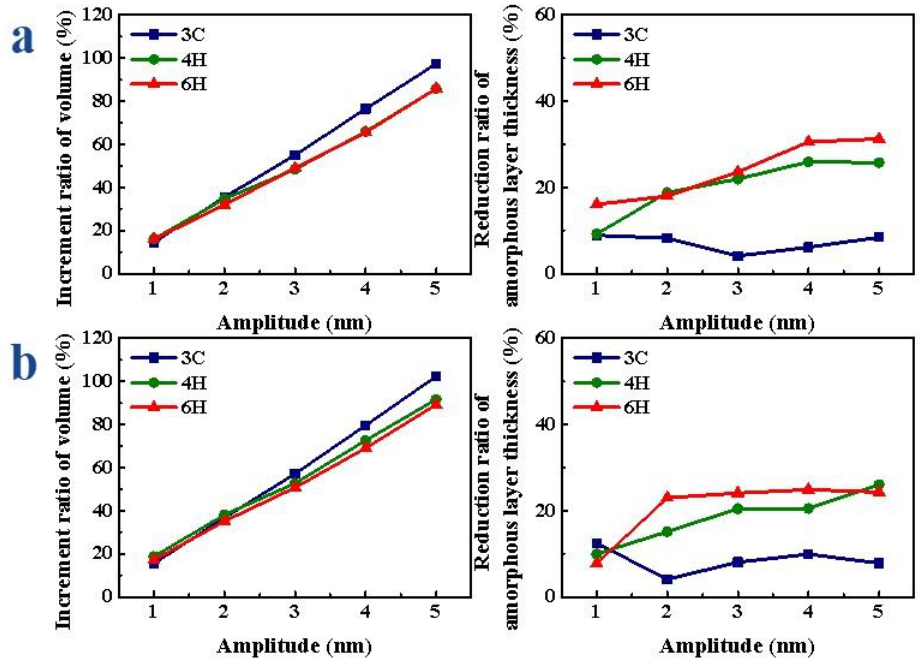
Figure 8. Amorphous atoms’ volume increment and amorphous atoms’ layer thickness reduction ratio of SiC polytypes with different amplitudes: ( a ) Si-face and ( b ) C-face of SiC.